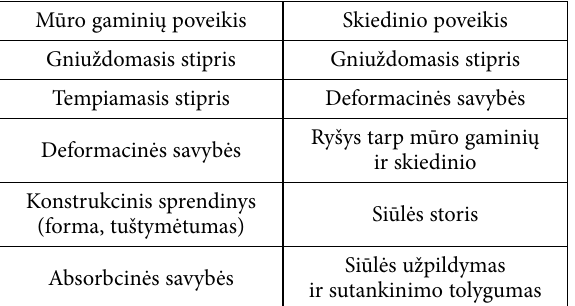
Table 1. Factors affecting mechanical properties of masonry